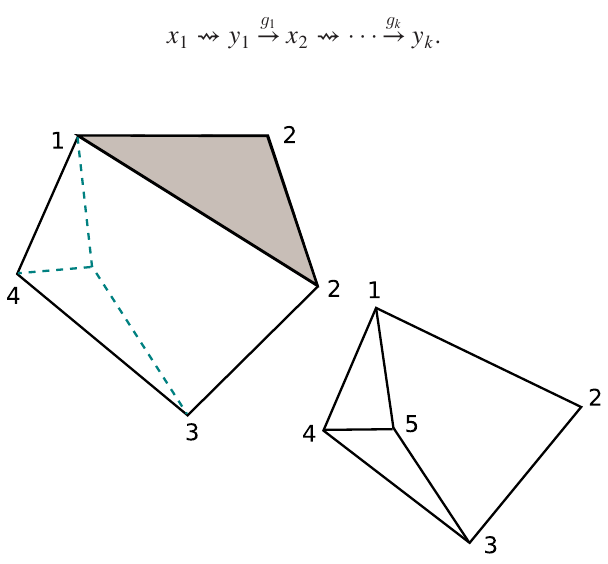
FIG. 14. Here, we depict a piece of M (northwest) mapping to a piece of X (southeast). We have given the vertices of X unique labels and labeled the vertices of M with their image vertices in X . Note that vertex 2 has two adjacent preimages. This edge of M is mapped to a degenerate edge, and the triangle it lies on (grey) is mapped to a degenerate face 122 in X . Note also that vertex 5 ∈ X has no preimage, and to map faces to faces, we must refine the lattice of M , depicted by the dotted blue